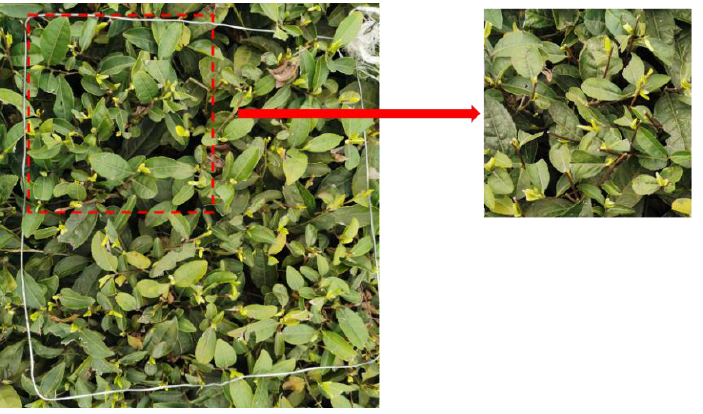
Figure 4. Data set image sample.